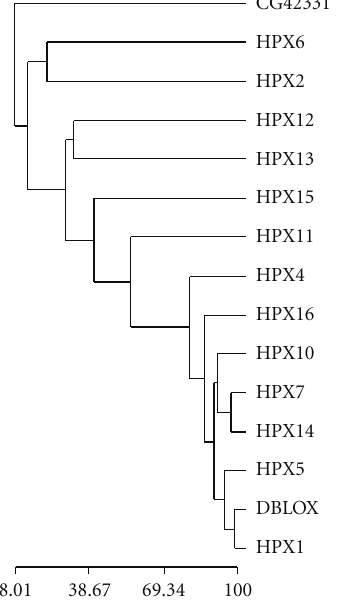
Figure 3: Hierarchical clustering of gene expression of 15 Anopheles gambiae HPXs across 11 tissue types. The scale on the left represents expression pattern similarity